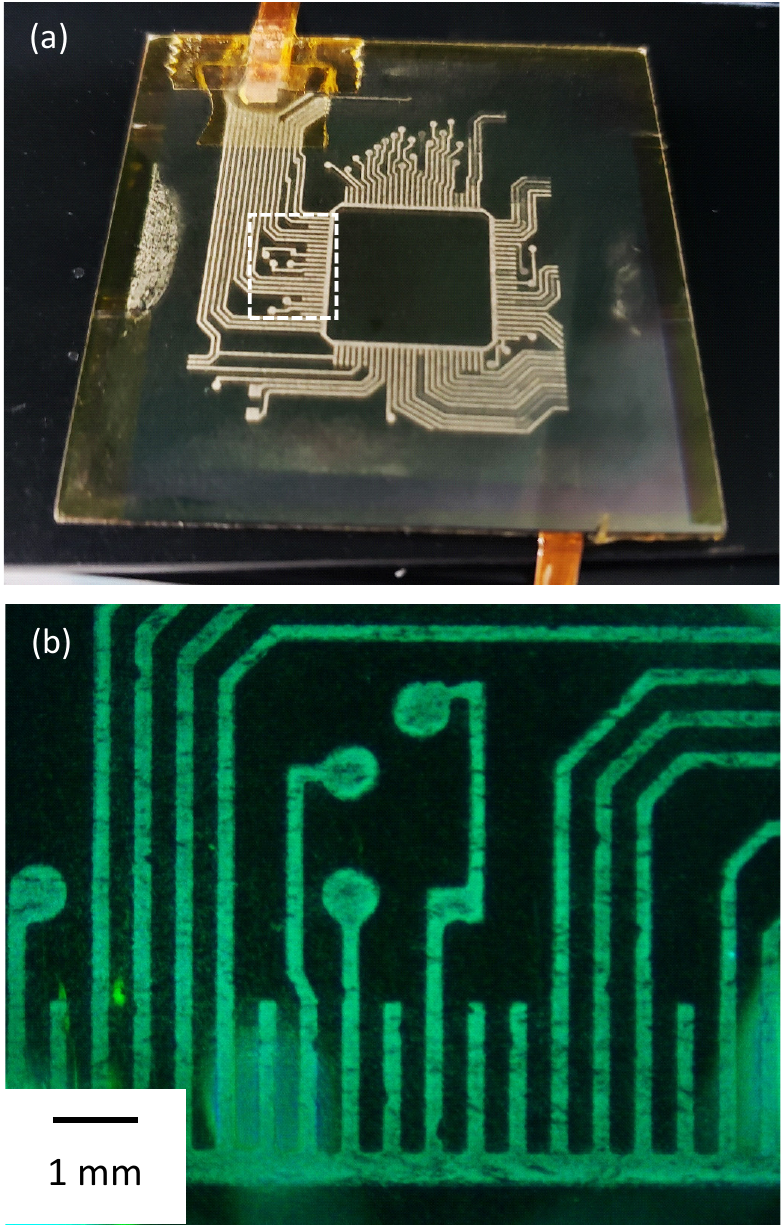
Figure 6. ( a ) Photograph of the Ag–Ni toner pattern formed with our toner printing method. ( b ) Op- tical micrograph of the Ag–Ni pattern indicated by the dashed rectangle in Figure 6a. The bright particles are the Ag–Ni